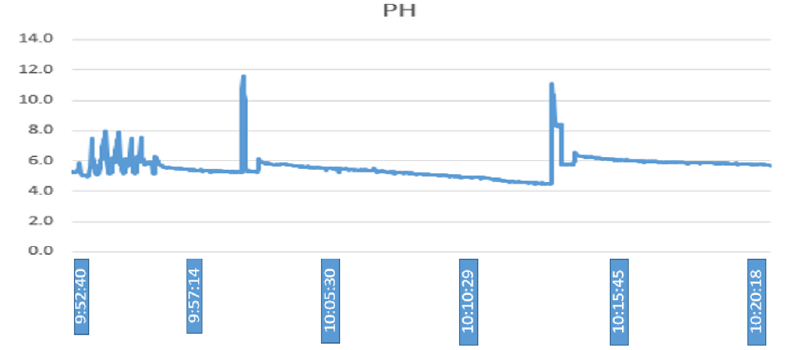
Figure 17. Nutrient pH. Table 5. PH fuzzy sets.